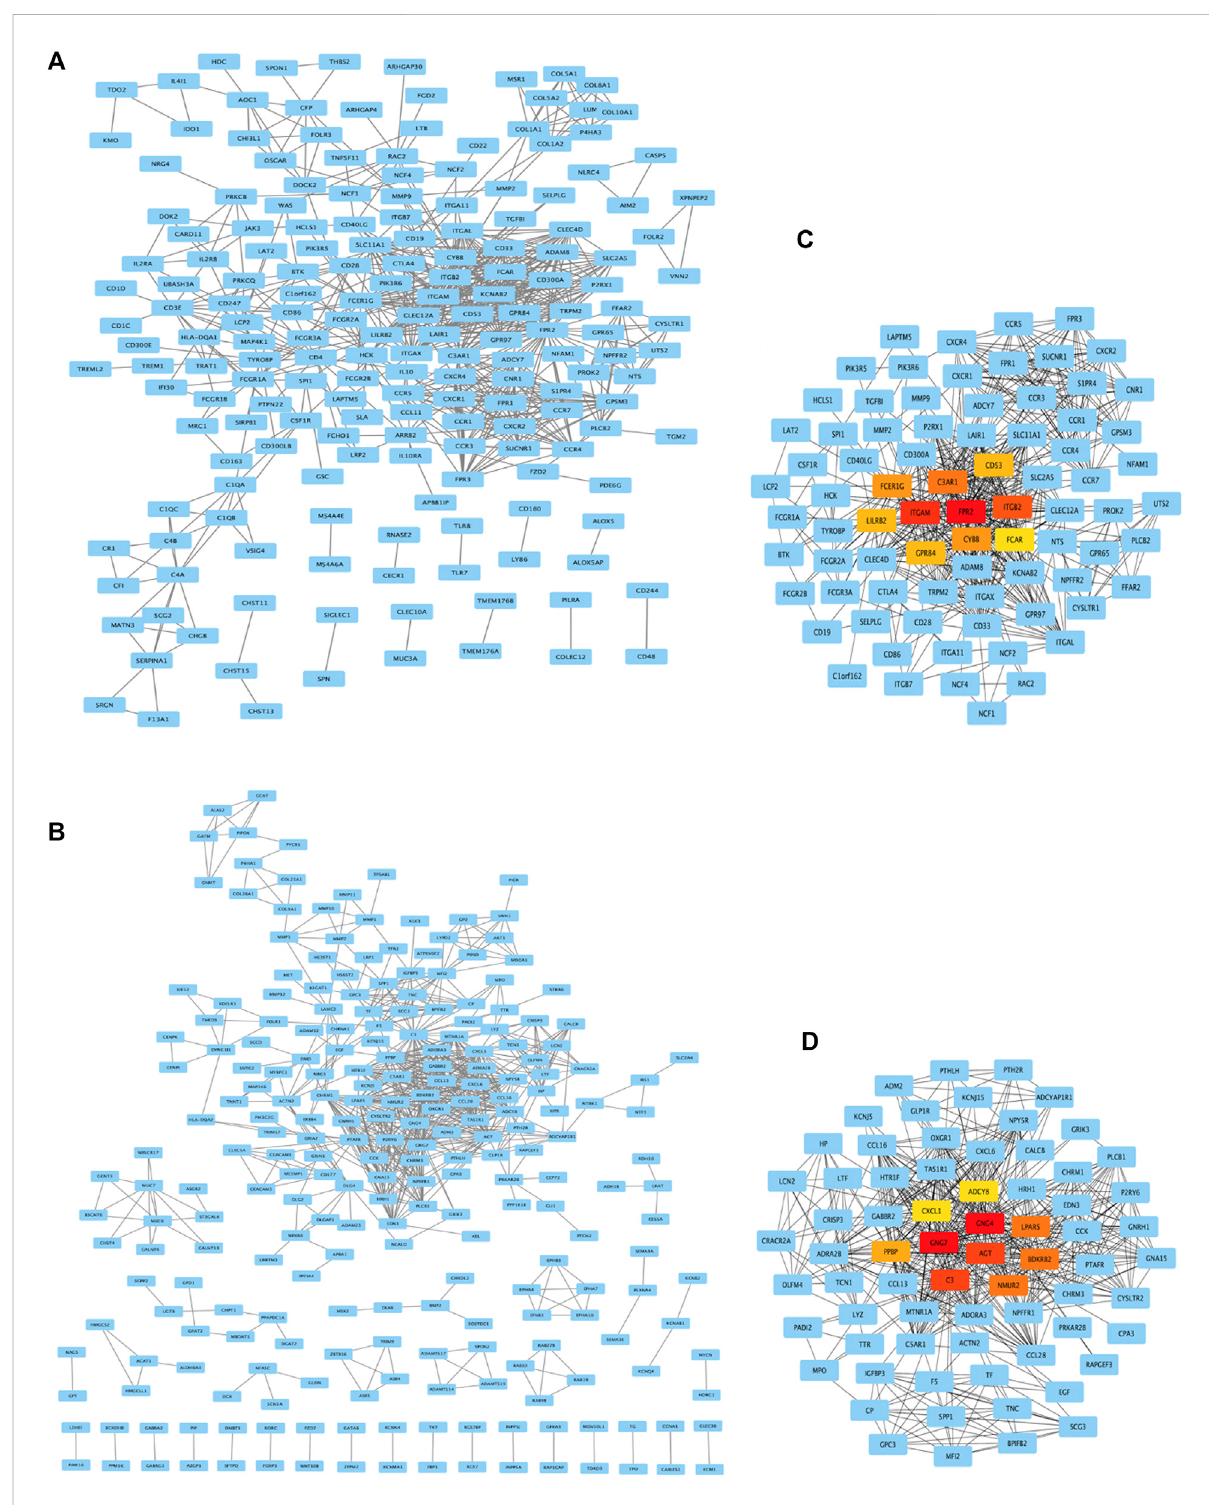
FIGURE 5 PPI network analysis and top-ten hub genes. (A,B) Genes from DEG-MEgreen and DEG-MEturquoise were put into PPI. (C,D) The top-ten connectivity genes in DEG-MEgreen and DEG-MEturquoise were visualized by Cytoscape. The ten highest degree genes in this PPI network were presented as red or orange nodes, where a node represents a gene and a line represents an interaction between